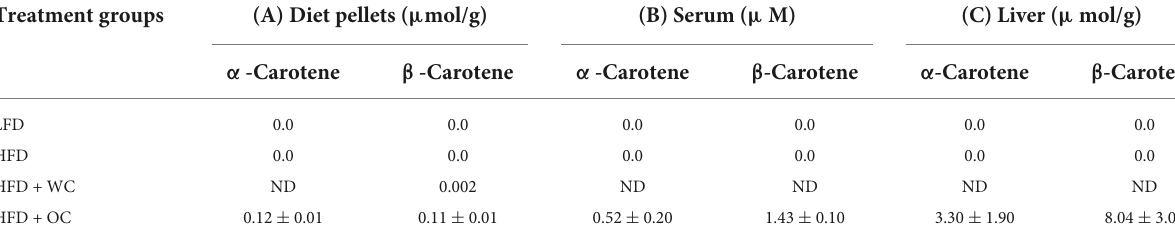
TABLE 1 α -Carotene and β -carotene concentrations in panel (A) diet pellets ( n = 3), (B) serum (LFD: n = 11; HFD, HFD + WC, HFD + OC: n = 12), and (C) liver (LFD: n = 11; HFD, HFD + WC, HFD + OC: n = 12). Treatment groups